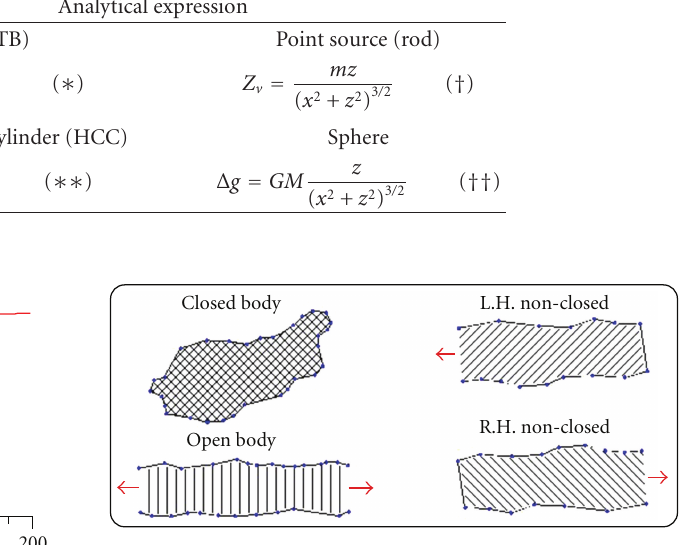
Figure 2: Types of geological bodies used in